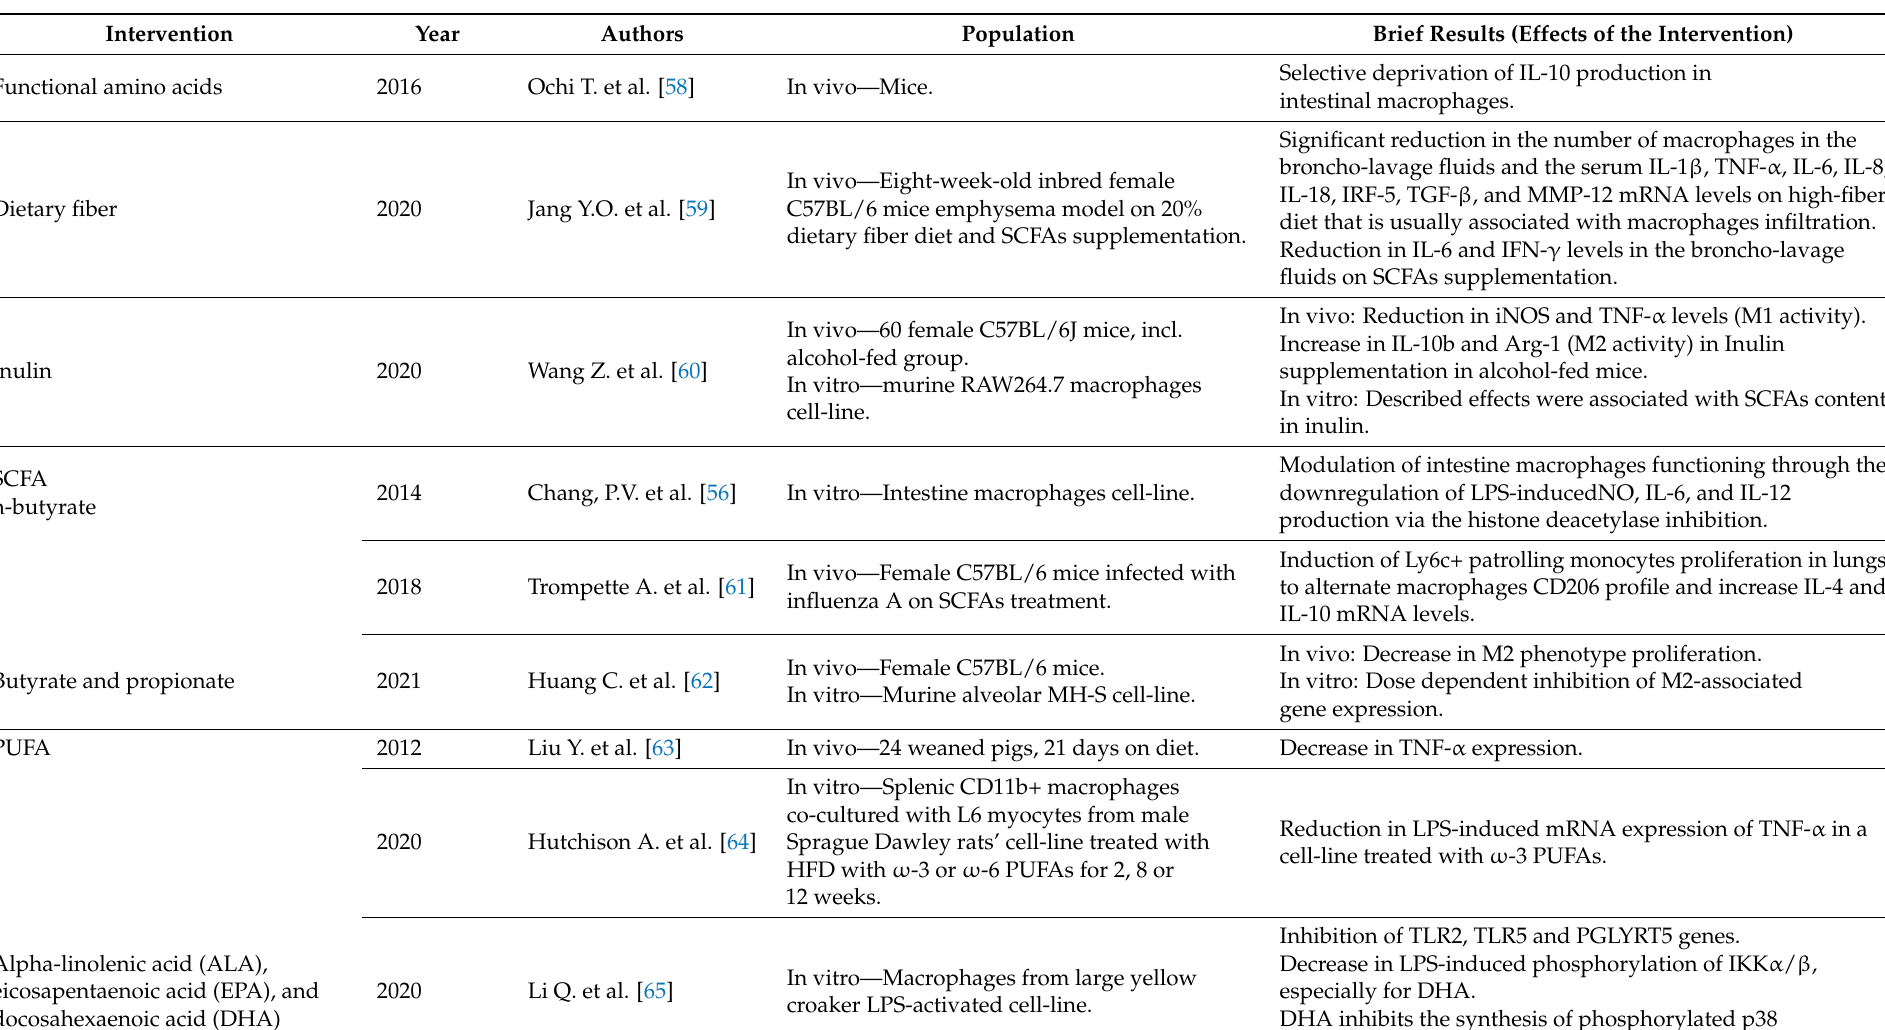
Table 2. Recent studies investigated the association of micronutrients and biologically active compounds with macrophage